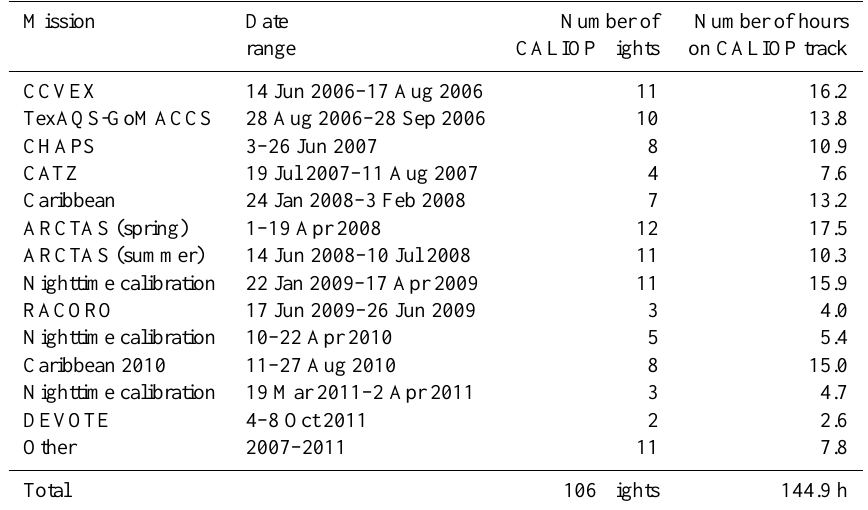
Table 1. Summary of HSRL flights and hours along the CALIPSO track for the field missions up to 2011 containing CALIOP validation components (updated from Rogers et al.,